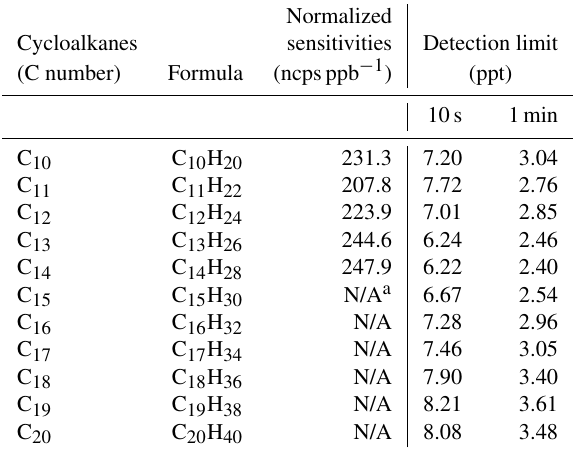
Table 2. Carbon numbers and formulas, mean normalized sensitiv- ities, and detection limits of cycloalkanes in NO + PTR-ToF-MS. Normalized sensitivities